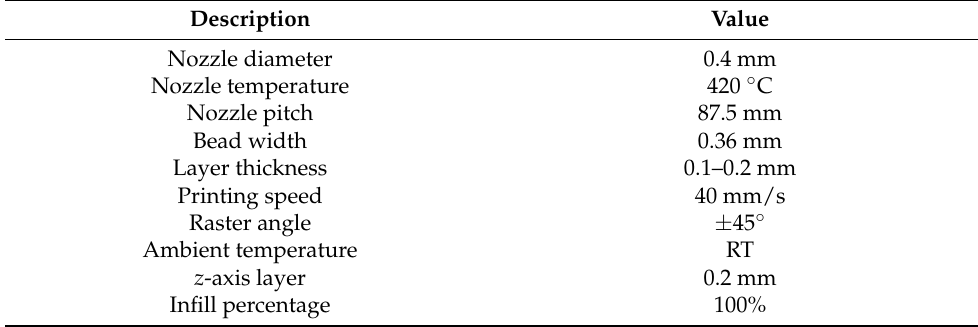
Table 2. Dual-nozzle 3D printing parameters.